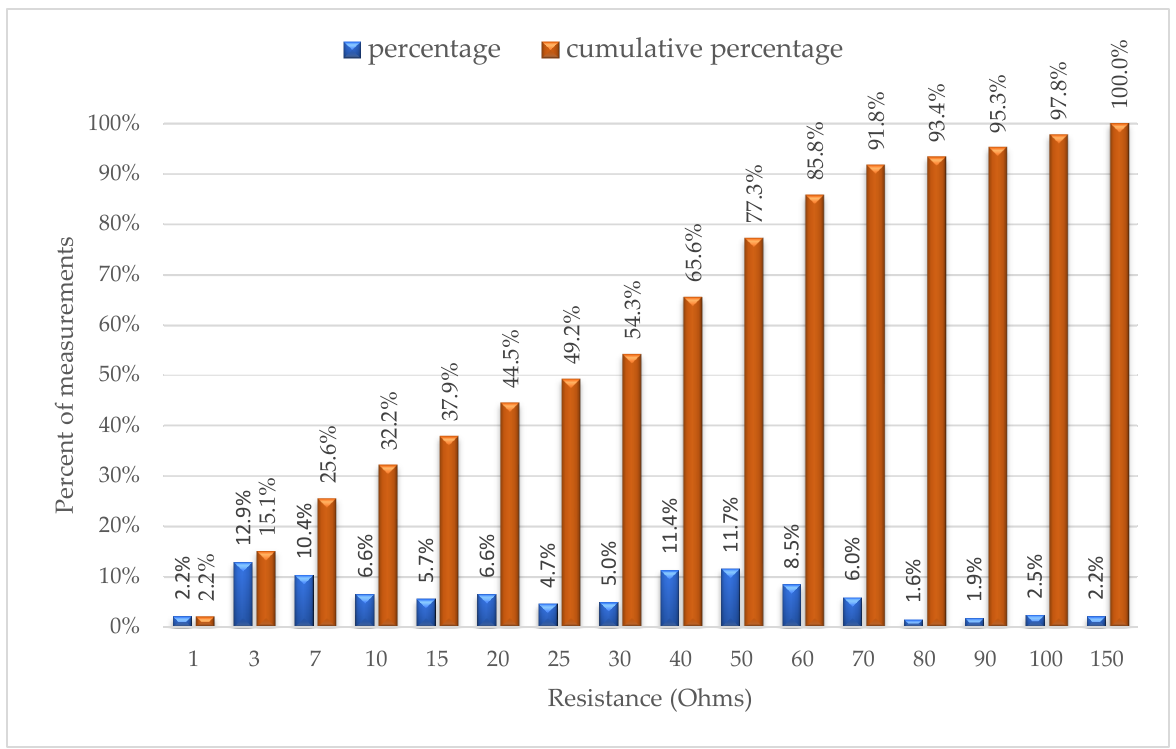
Figure 7. Percent of wind turbine earthing resistance measurements per geographical department of Greece.